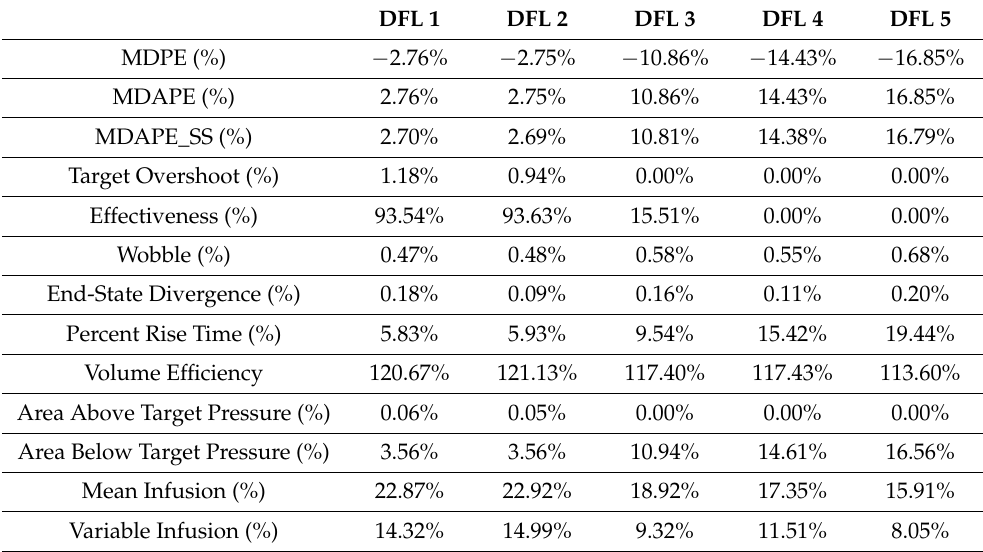
Table A4. Summary of performance metrics for Scenario 4. Performance metrics for each of five DFL controllers is shown as mean values for three subject variability